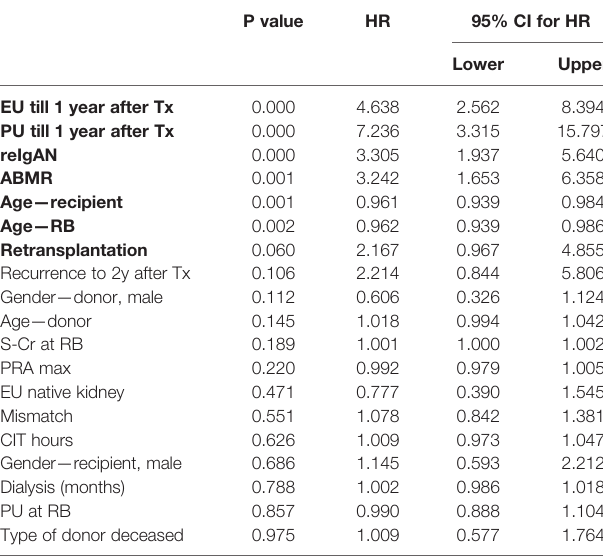
TABLE 5 | Analysis of risk factors for graft survival in patients with IgAN in biopsy of native kidney. P value HR 95% CI for HR Lower Upper